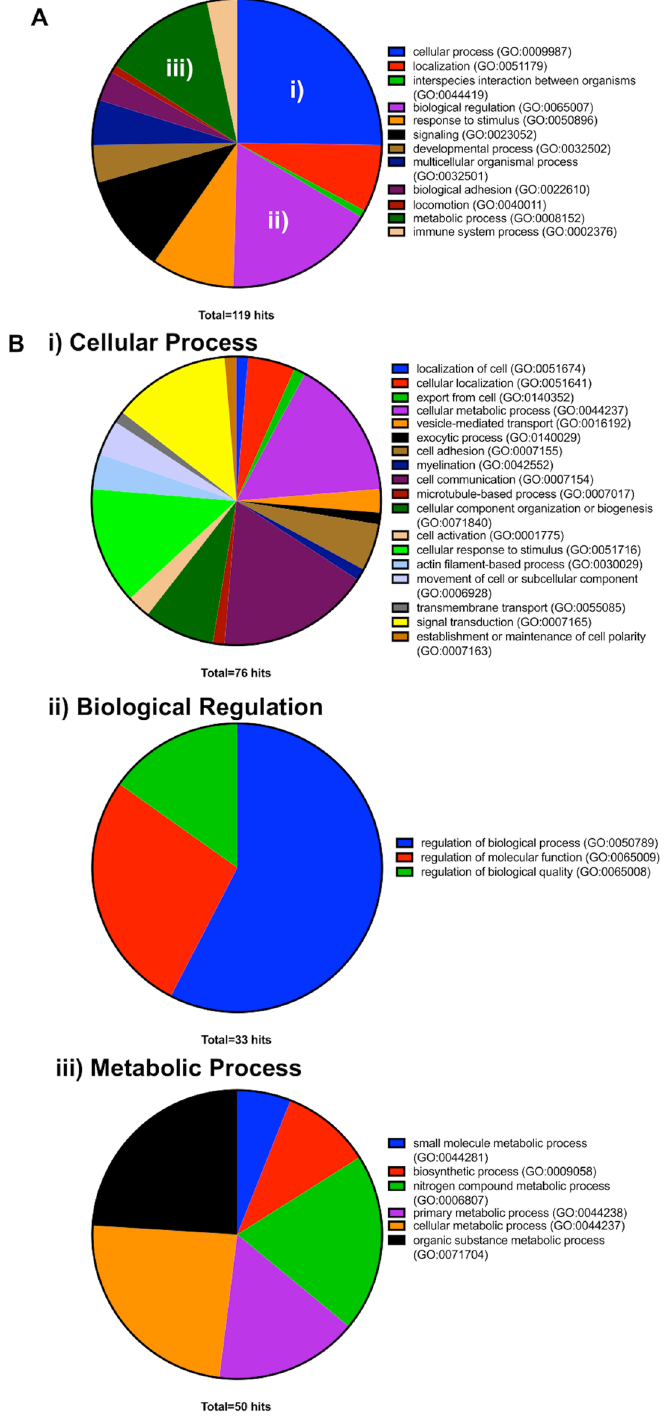
Figure 4. Gene ontology analysis of 57 nuclear PAI-1 regulating genes. ( A ) Biological process and ( B ) details of biological process including (i) cellular process, (ii) biological regulation, and (iii) metabolic